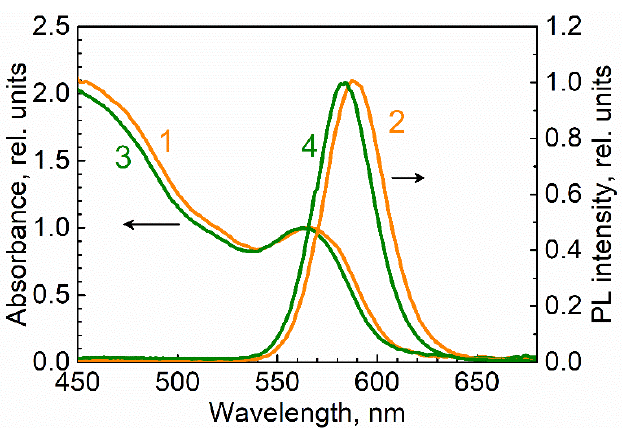
Figure 2. Absorption (1, 3) and normalized PL (2, 4) spectra of QD covered (stabilized) by TOPO in chloroform (1, 2) covered by and dissolved in 2-carboxyethyl acrylate (3, 4).